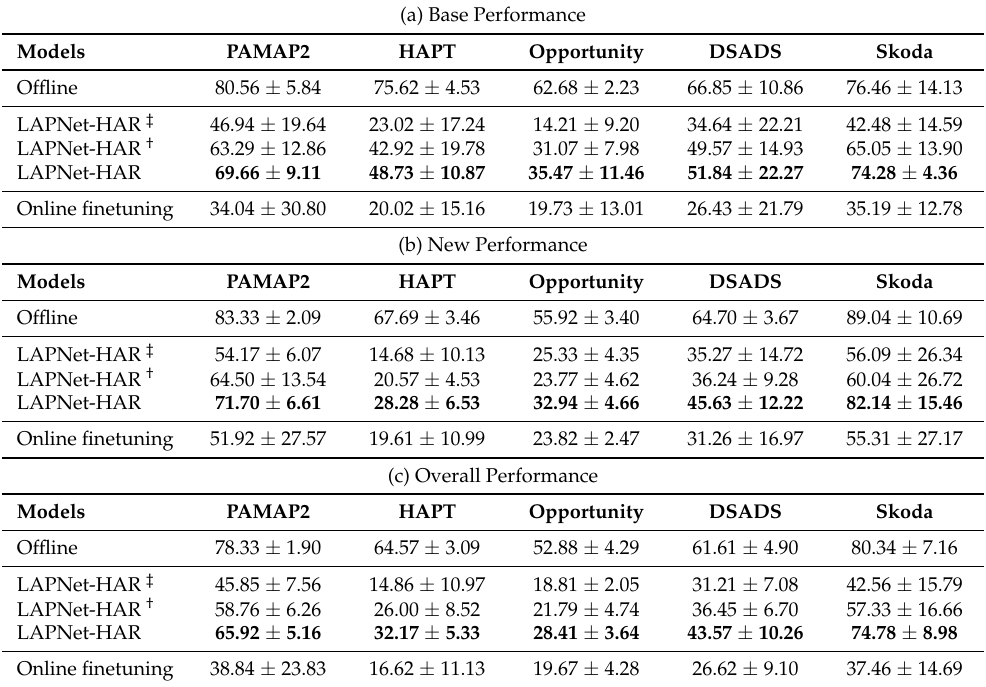
Table 4. Summary Results. ‡ : without experience replay and contrastive loss, † : without contrastive